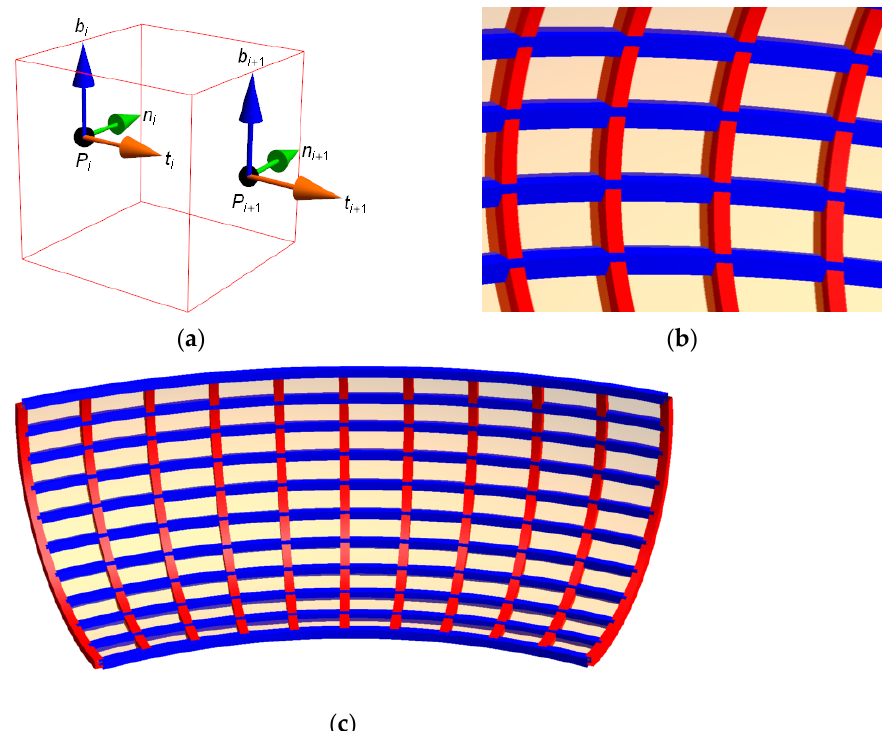
Figure 3. Visualization of LoCs as square pipes on LA surface of revolution for α = 2. ( a ) Frenet-Serret frame; ( b ) Close-up view of LA surface of revolution; ( c ) Curvature lines on LA surface of revolution.